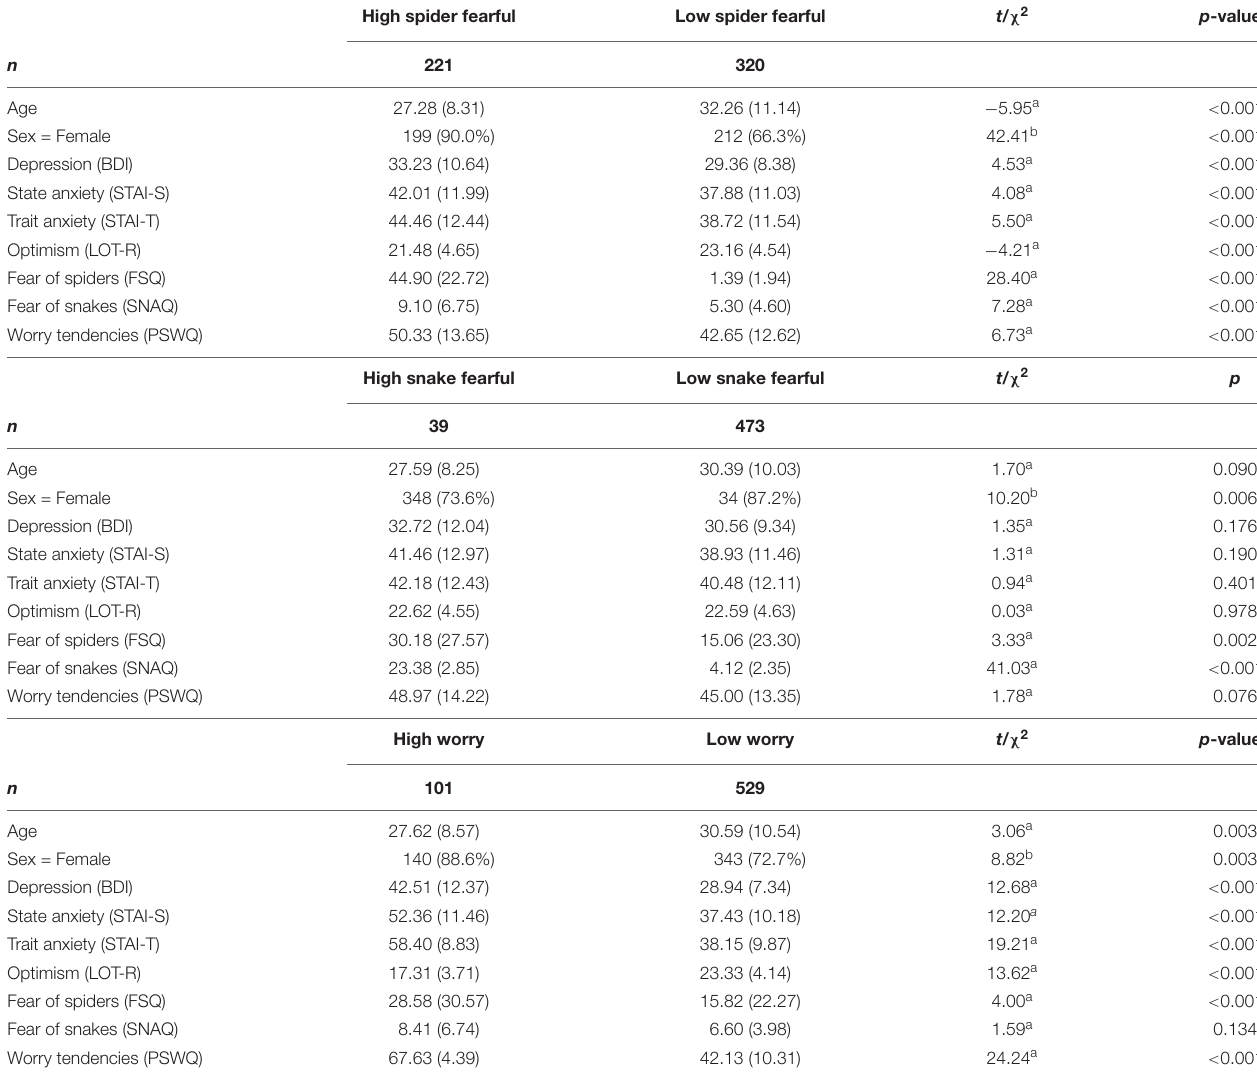
TABLE 1 | Demographics and questionnaire